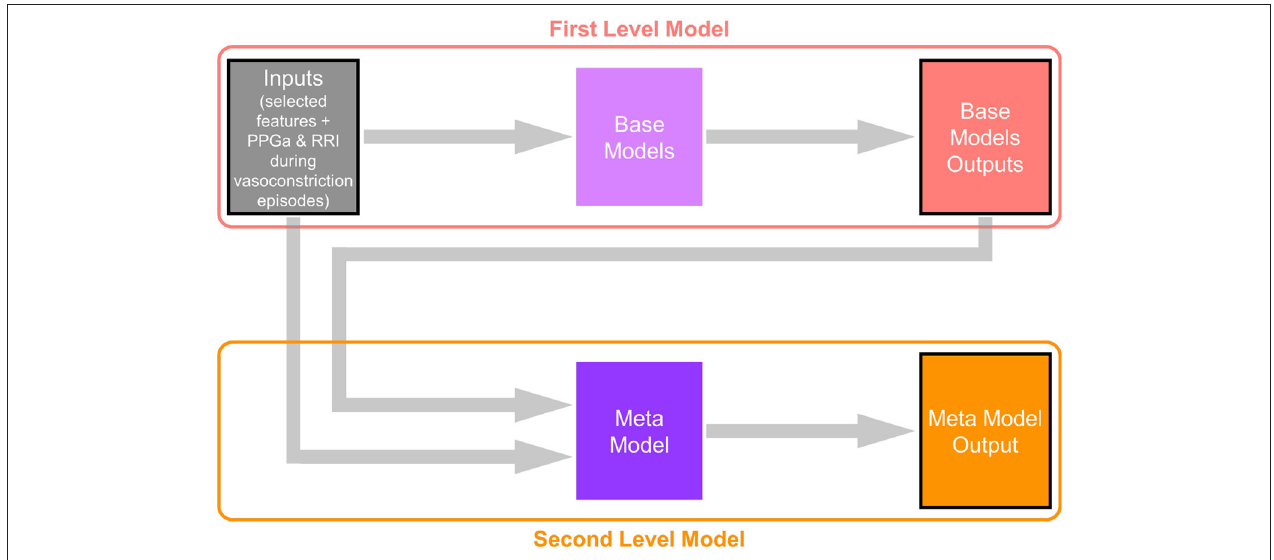
FIGURE 2 | Architecture of the two-level stacking model. The base models in the first level take subjects’ physiological and ANS features as input (the CNN base-model takes PPGa and RRI time-series around the detected vasoconstriction events). The meta model in the second level takes both subject features and the outputs of base models (prediction of subjects’ pain categories) as inputs, and makes the final prediction.